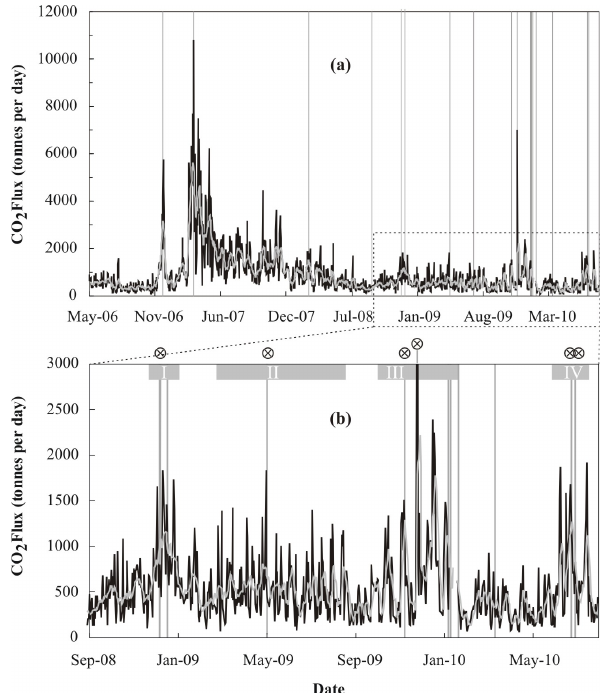
Fig. 2. (a) Daily averages of CO 2 plume fluxes (in tonnes per day) from Stromboli’s summit crater, between May 2006 and July 2010 (the weekly mobile average is given as a light grey line). The period from 15 September 2008 to 30 July 2010 is detailed in (b) . The dashed areas labelled I to IV denote the 4 main phases of CO 2 flux increase, discussed in the text. Major explosions, indicated by the vertical grey lines (and crosses for the strongest ones), typically clustered during these phases of high CO 2